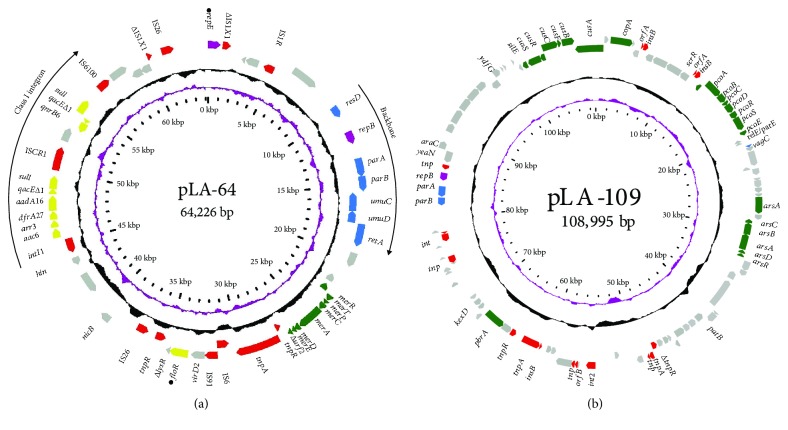
Genomic structure of the plasmids pLA-64 (a) and pLA-109 (b). Genes are denoted by arrows and are colored based on gene function classification. Counting from the outside toward the center: (1) genes encoded on the leading strand (outwards) or the lagging strand (inwards) with the hypothetical protein left blank; (2) an average G+C content of 50%, whereas a G+C content of more than 50% is shown toward the outside and a G+C content of less than 50% toward the inside; (3) GC skew (G–C/G+C) with a positive GC skew toward the outside and a negative GC skew toward the inside; and (4) scale in bp. Genes with different functions are shown in different colors: red: transposable elements; yellow: drug resistance; green: heavy metal resistance; blue: backbone; purple: replication; gray: genes with other functions.